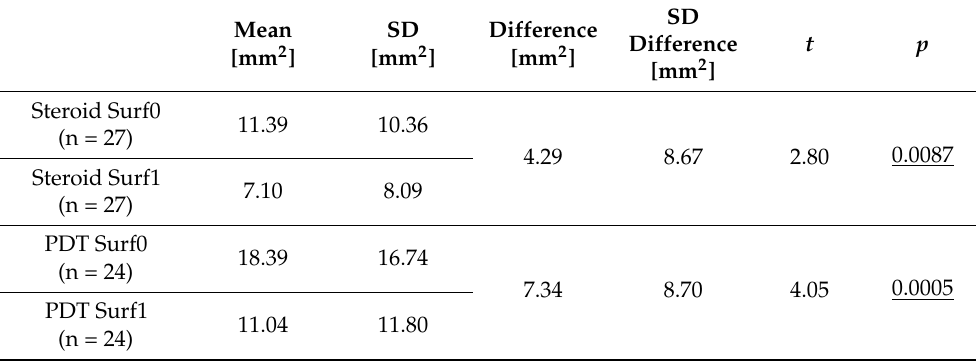
Table 3. Results of paired Student t -test. Comparison size of surface before (Surf0) and after (Surf1) treatment for local steroid (steroid) and photodynamic therapy (PDT) treatment (SD—standard deviation, t —value of Student t -test, underlined— p <